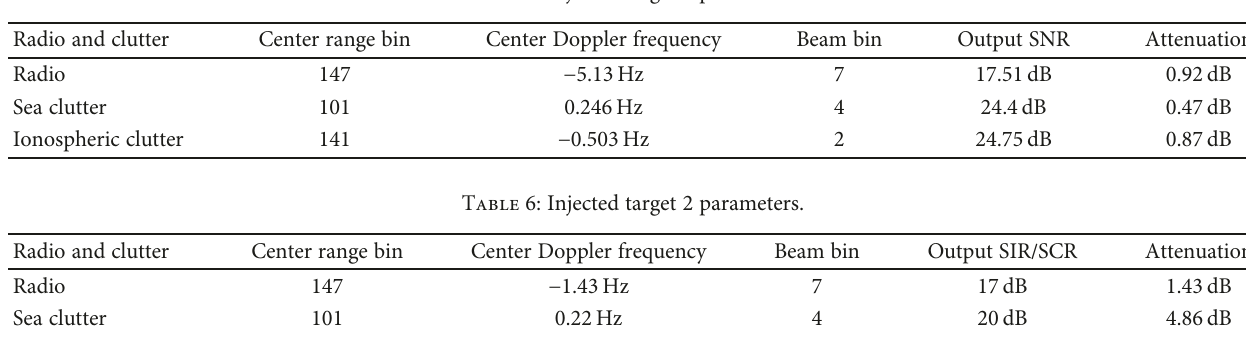
Table 5: Injected target 1 parameters.